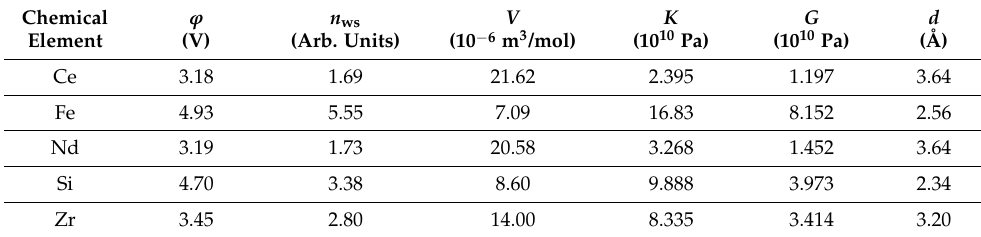
Table 1. Basic parameters used in the calculations of enthalpies of formation [24,37]. Chemical